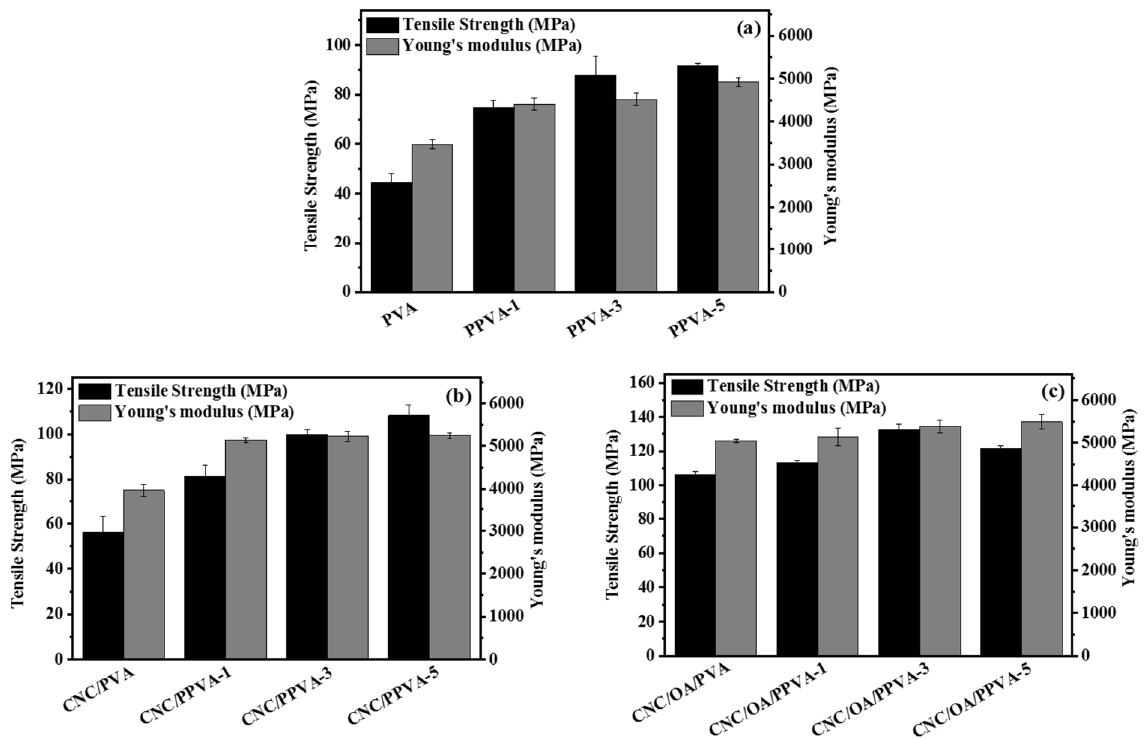
Figure 1. Tensile strength and Young’s modulus of different films without or with air plasma treatment. ( a ) PVA and its air plasma-treated films (PPVA-1, PPVA-3, and PPVA-5 are referring to the PVA films exposed to air plasma irradiation by 1 min, 3 min, and 5 min, respectively.); ( b ) CNC/PVA and its air plasma-treated films (CNC/PPVA-1, CNC/PPVA-3, and CNC/PPVA-5 are referring to the CNC/PVA films exposed to air plasma irradiation by 1 min, 3 min, and 5 min, respectively.); ( c ) CNC/OA/PVA and its air plasma-treated films (CNC/OA/PPVA-1, CNC/OA/PPVA-3, and CNC/OA/PPVA-5 are referring to the CNC/OA/PVA films exposed to air plasma irradiation by 1 min, 3 min, and 5 min, respectively).